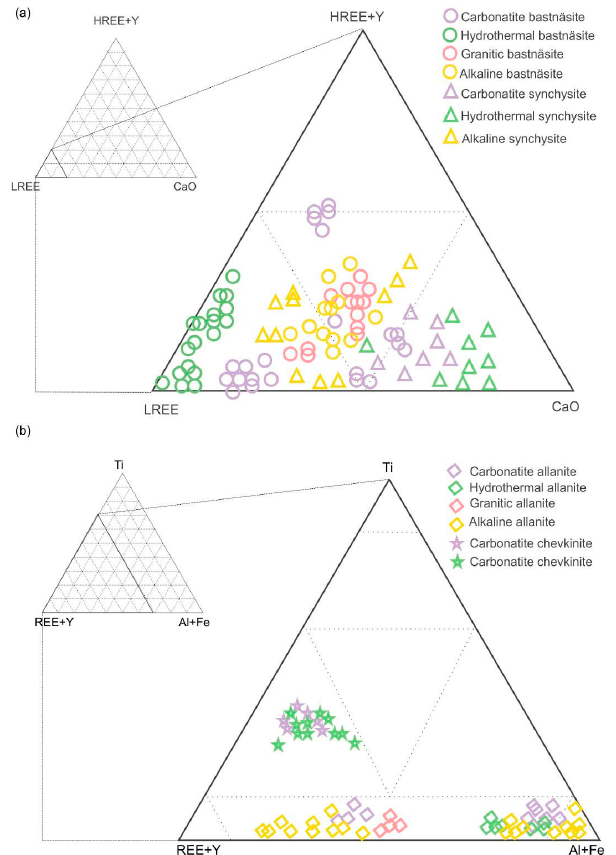
Figure 21. Compositions of Ca-REE fluorocarbonates in the (LREE)–(HREE + Y)–Ca ternary diagram (mol %) ( a ); and REE silicate minerals in the (REE + Y)–Ti–(Al + Fe) ternary diagram (mol %) ( b ); from different types of REE deposits and occurrences in Finland.